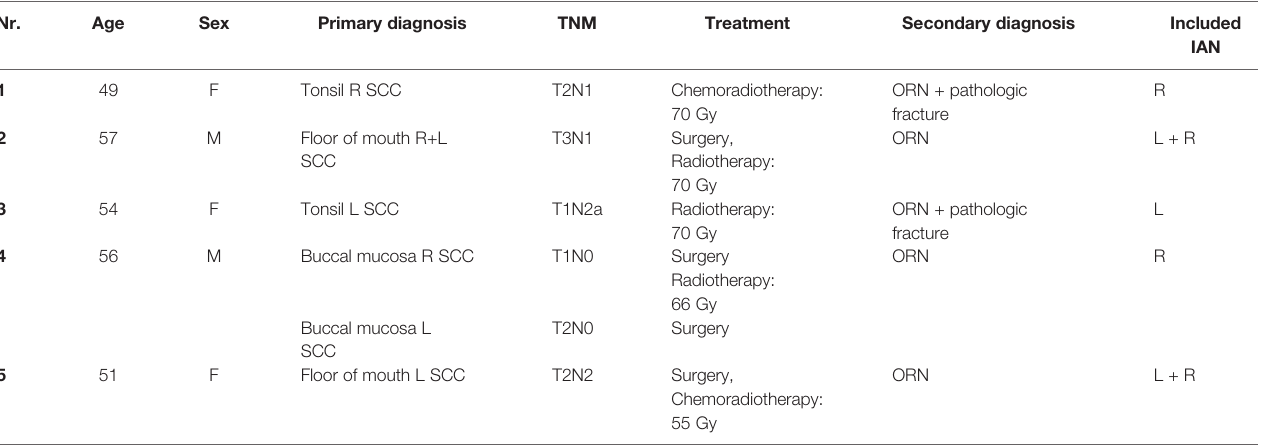
TABLE 2 | An overview of the included patients and their characteristics.